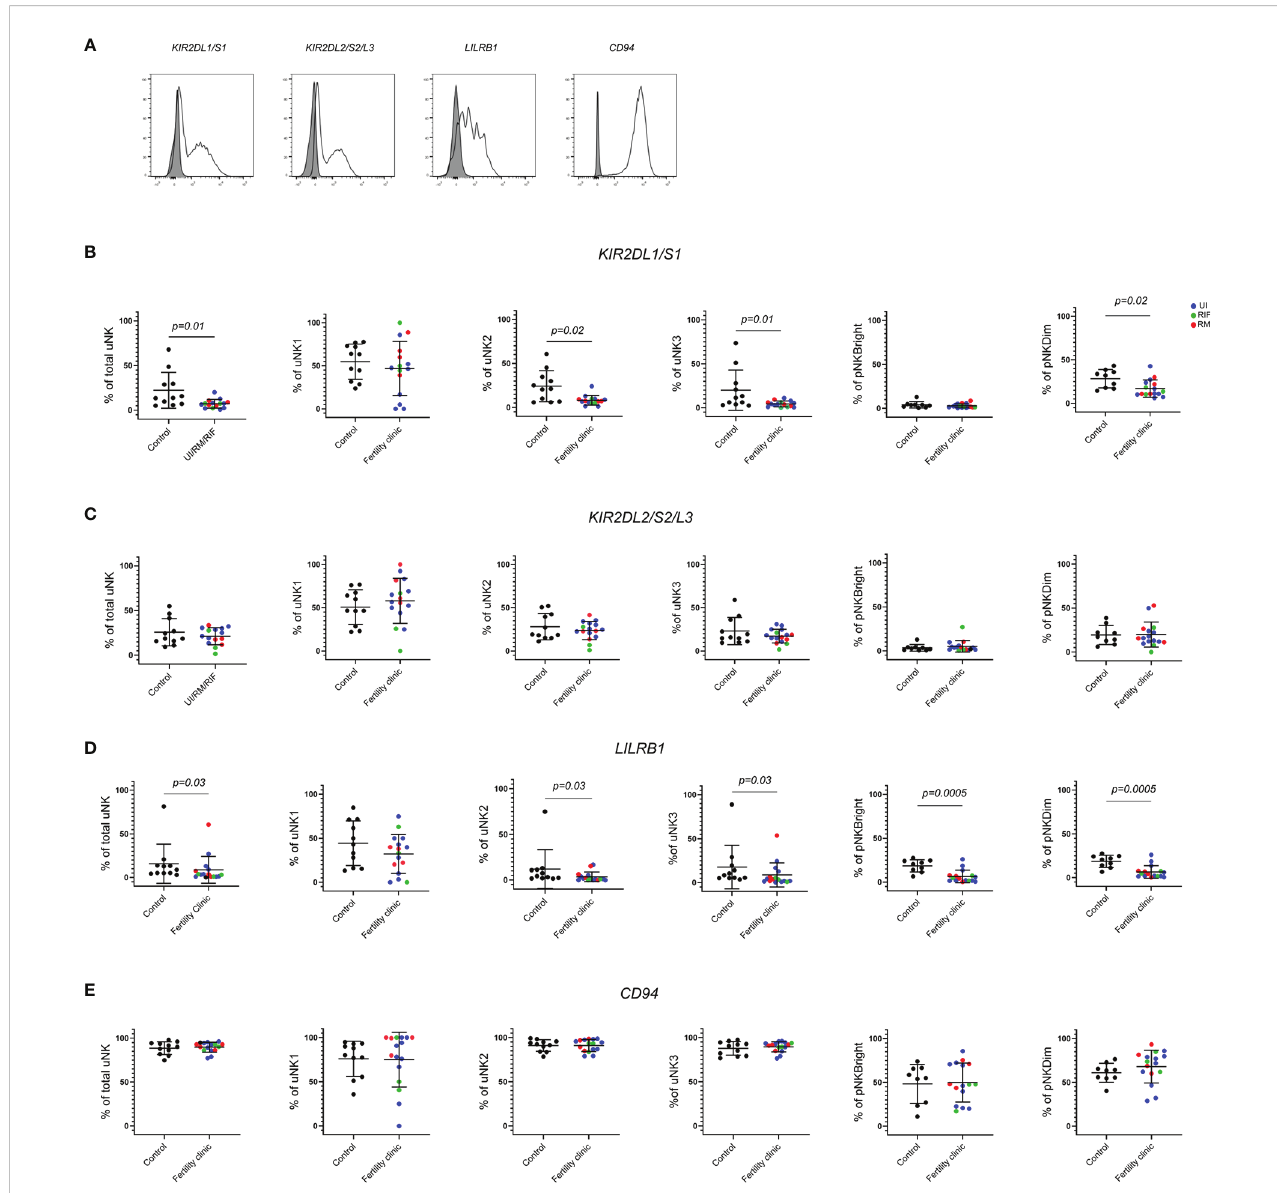
FIGURE 2 KIR2DL1/S1 and LILRB1 expression is lower in women with reproductive failure. (A) Uterine and peripheral NK cells taken from control and UI, RM and RIF groups were freshly stained for phenotypic markers. Representative staining of two samples from total uNK are shown in clear alongside fl uorescence minus one control in grey. Graphs showing frequencies of KIR2DL1/S1 (B) , KIR2DL2/3 (C) , LILRB1 (D) and CD94 (E) on uNK and pNK. Means and standard deviations are shown for controls (n=11) shown in black and patients from fertility clinic including unexplained infertility (UI; n=9) showed in blue, recurrent miscarriage (RM; n=4) shown in red and recurrent implantation failure (RIF; n=3) shown in green. Statistical testing was done using unpaired t- test for normal or Mann-Whitney U test for non-normal distribution and p-values are shown on the graphs. Holm-Bonferroni correction for multiple hypothesis testing showed no signi fi cance except for LILRB1 on pNKBright and pNK Dim which remained signi fi cant at p ’